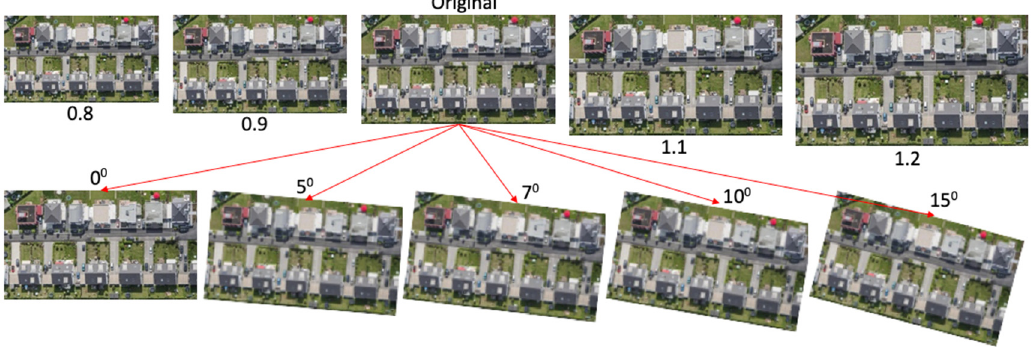
Figure 5. Five images from the scaling dataset and five from the rotation dataset.